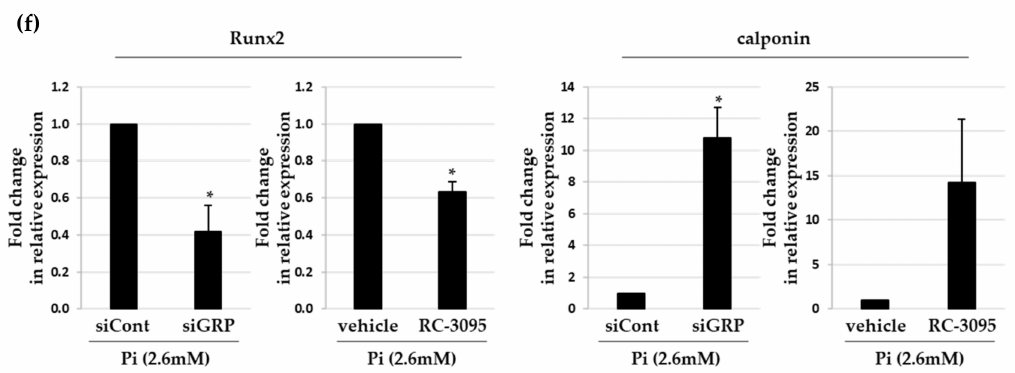
Figure 2. E ff ect of GRP silencing and RC-3095 treatment on Pi-induced osteogenic di ff erentiation